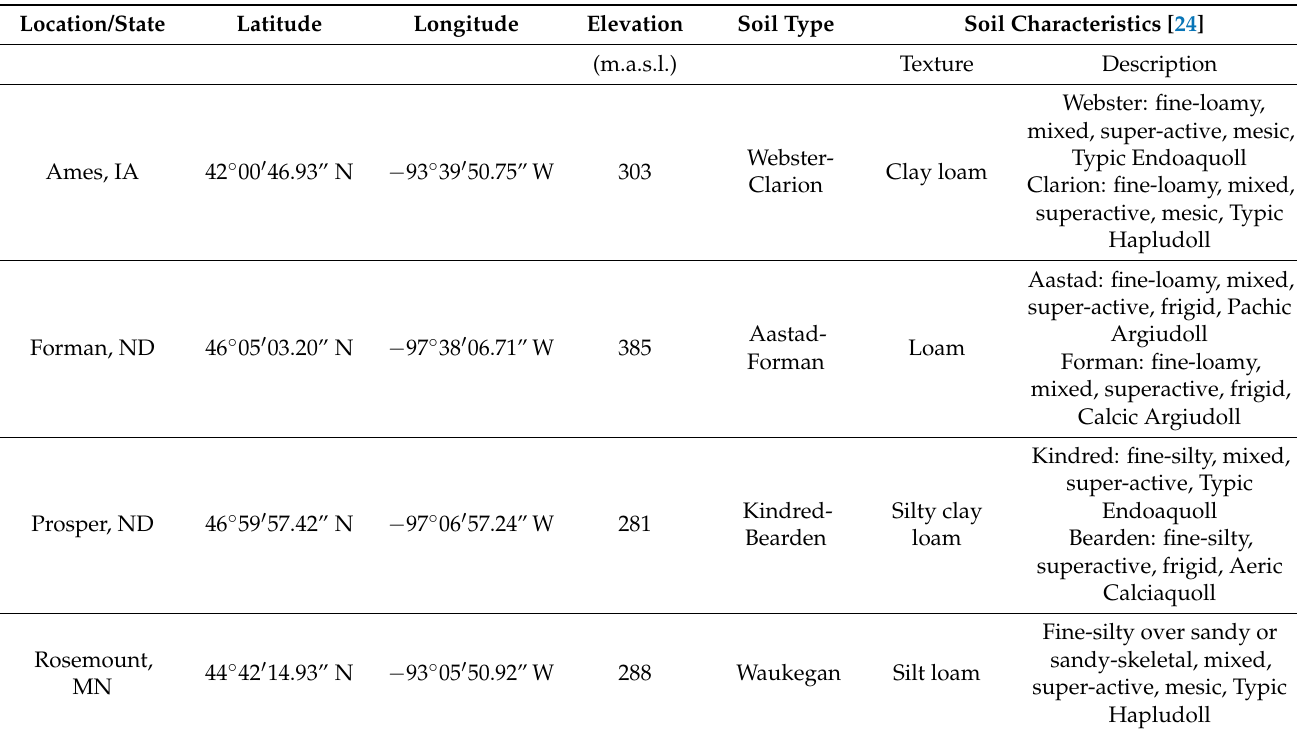
Table 1. Locations and soil description.